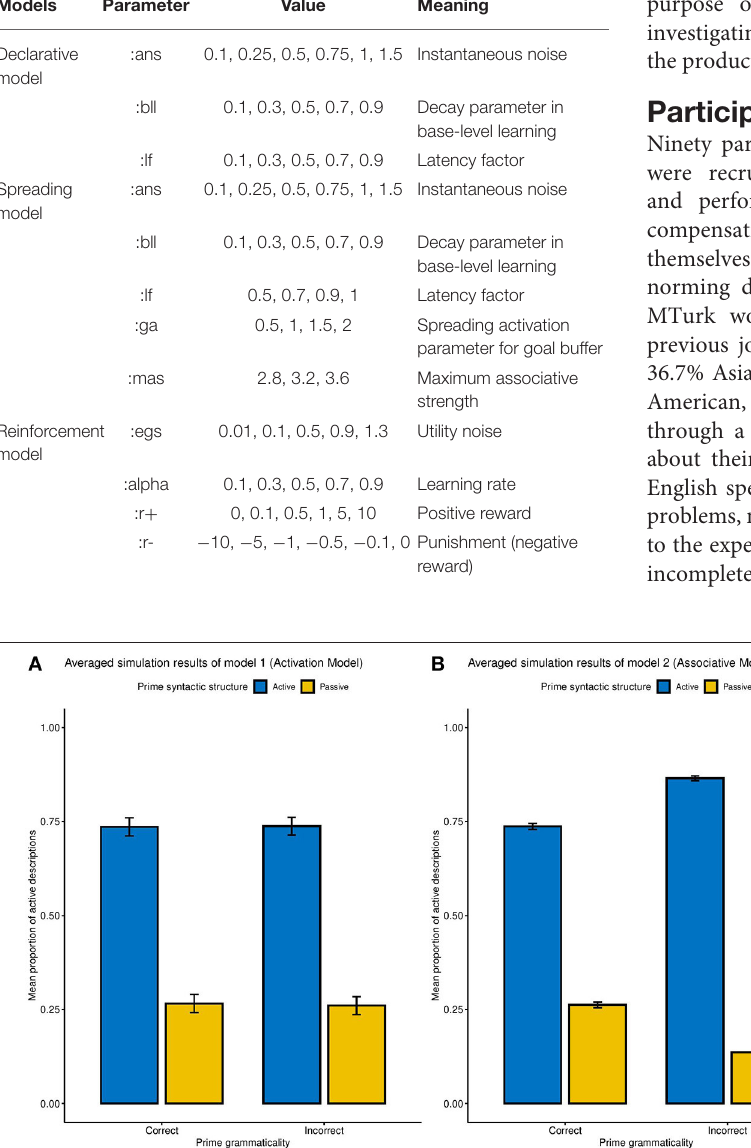
Frontiers in Psychology |